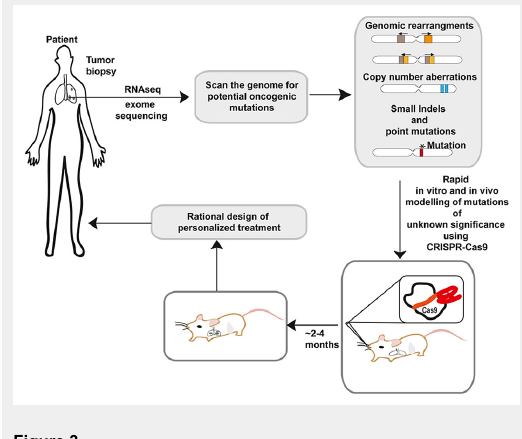
Applications of CRISPR-Cas9 in personalized medicine. A possible scenario for the use of CRISPR-Cas9 in personalized medicine. Genetic information derived from high-throughput analysis of the patient’s tumor samples often results in the identification of mutations of unclear pathogenetic significance in known oncogenes and tumor suppressors. CRISPR could be used to model such mutations in vitro and in vivo and rapidly determine their functional consequences. Such information can then be used to design an optimized personalized